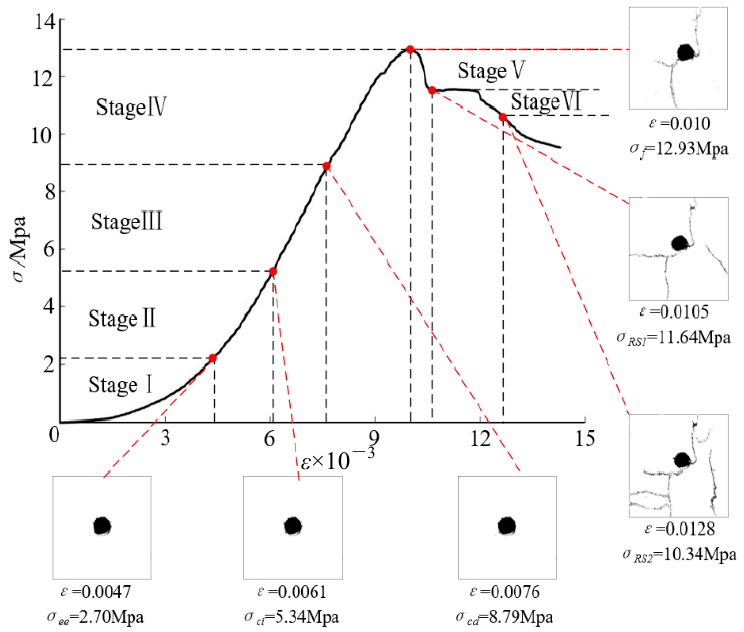
Figure 1. Test system and specimens.